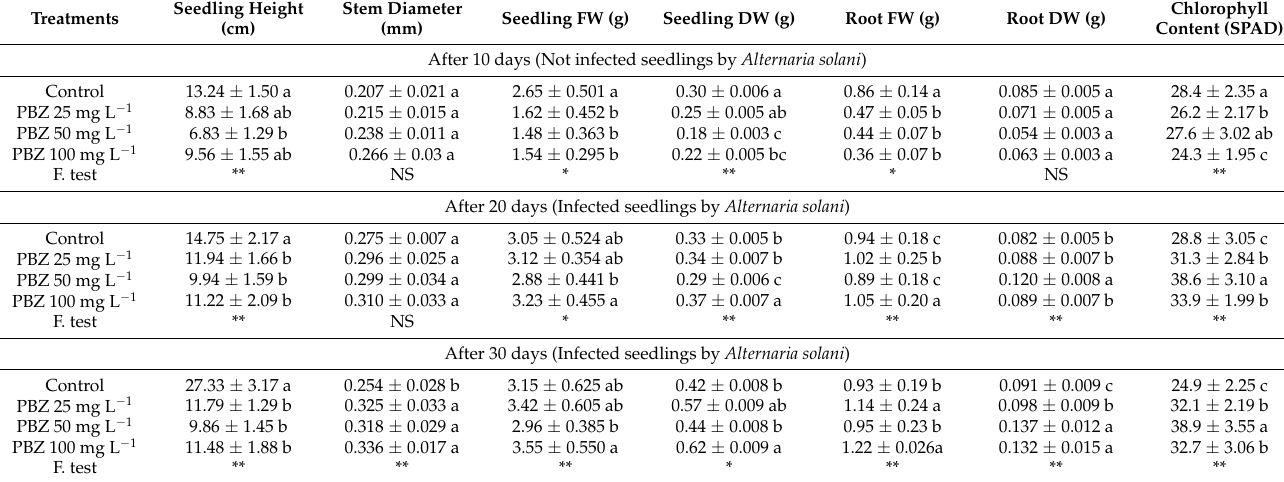
Table 4. Response of some vegetative growth parameters and chlorophyll content to PBZ doses after 10, 20, and 30 days from PBZ foliar application (during April 2021) (with/without infection by Alternaria solani ).